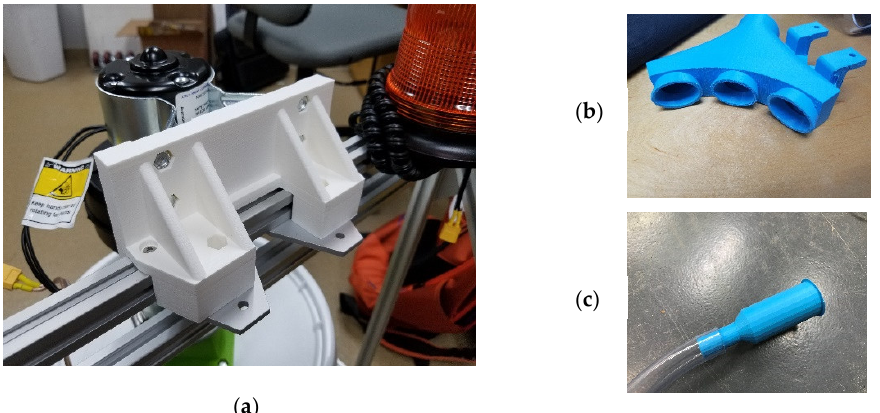
Figure 4. ( a ) Blower mount to an aluminum extrusion, ( b ) three suction ports, and ( c ) single suction port.